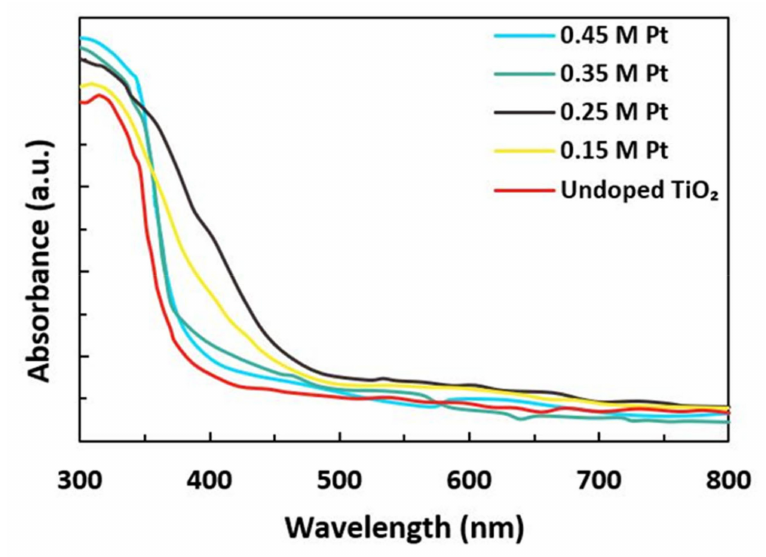
Figure 3. Absorption spectra of undoped TiO 2 and Pt-doped TiO 2 at different molar concentrations. It is also clear from Figure 3 that after doping, the absorption edge shifted from 360 nm to 460 nm. This shift was ascribed to the reduction of the bandgap. This observation was the same as the reported value of Chunqiao et al. in the case of doping of TiO 2 by La and Eu [27]. The bandgap energies (E g ) of synthesized material were found using the Tauc formula given by Equation (2): When the value of ( α h ν ) 2 was plotted on the y-axis, and photon energy E (eV) was plotted on the x-axis, then the pattern of this graph was as shown in Figure 4.